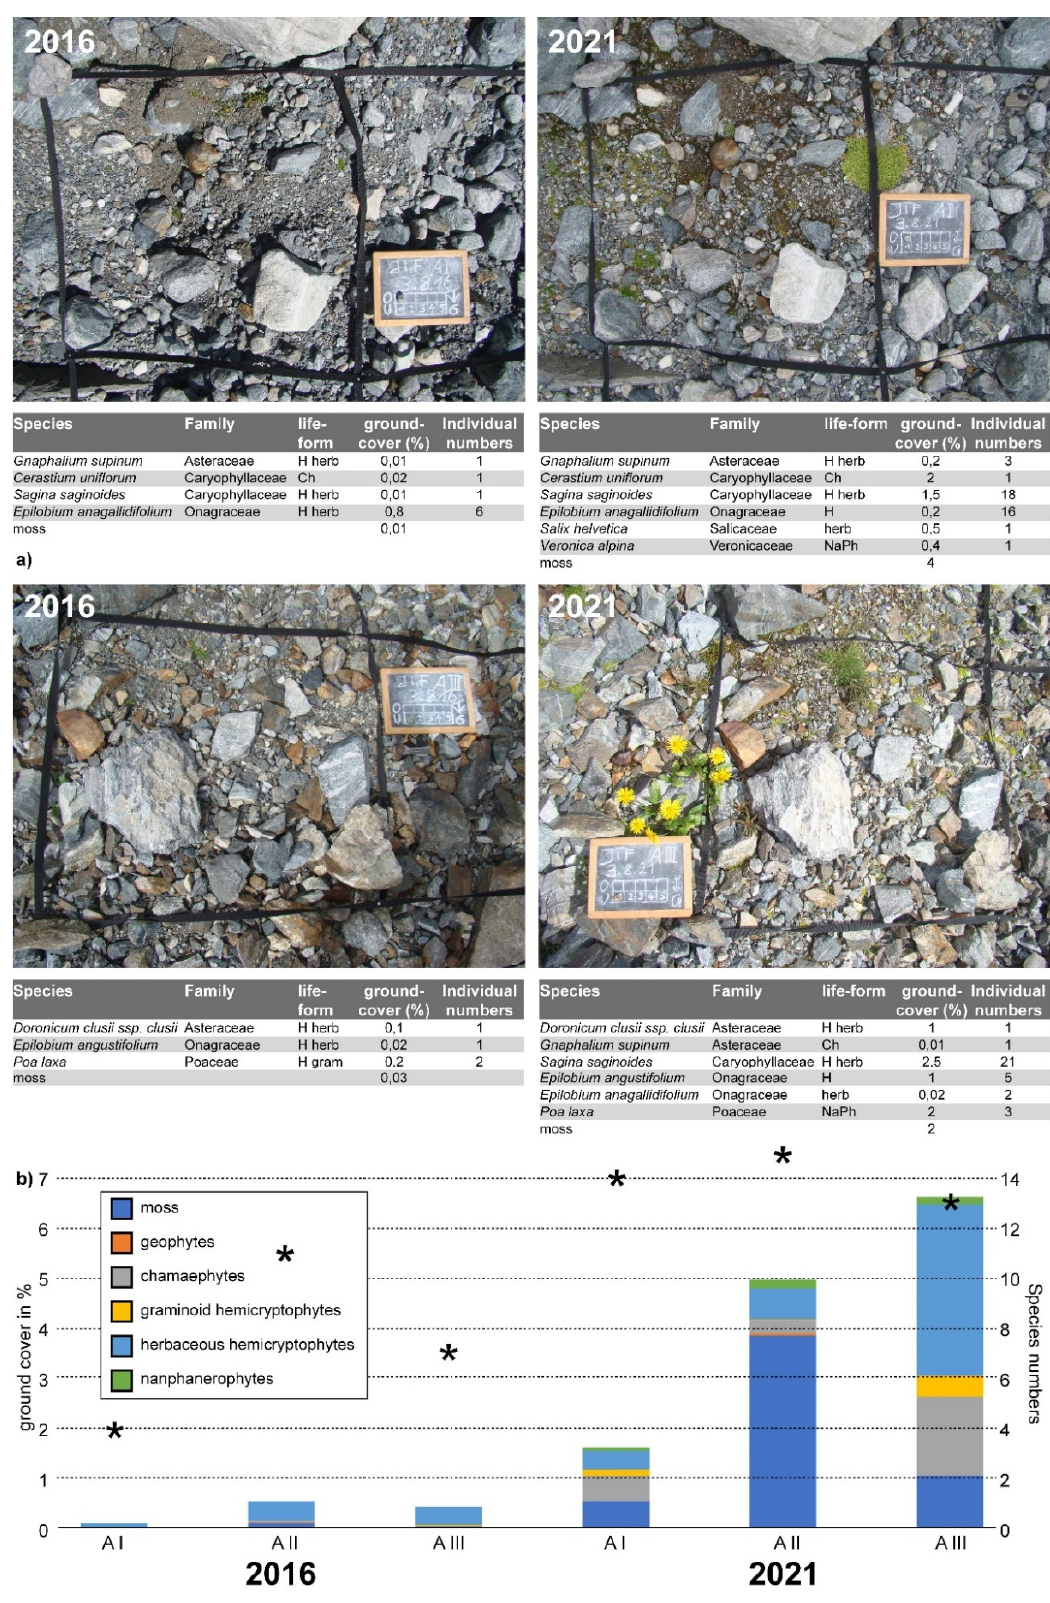
Figure 11. Rapid colonization of newly emerged supraglacial debris on Jamtalferner (European Alps, Austria): ( a ) illustrative photo-pairs of two 1 m 2 sample plots in 2016 and 2021; ( b ) changes in ground cover and life-form composition (bars) along with species numbers (asterisks) of three samples AI, AII and AIII (10 m 2 each) between 2016 and